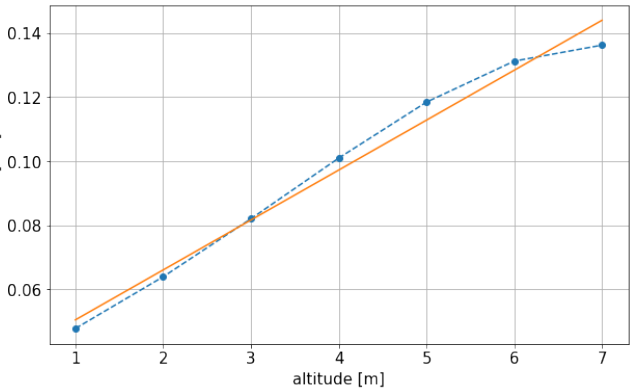
Figure 10. Obtained function, interpolated and scattered values for the vertical equilibrium